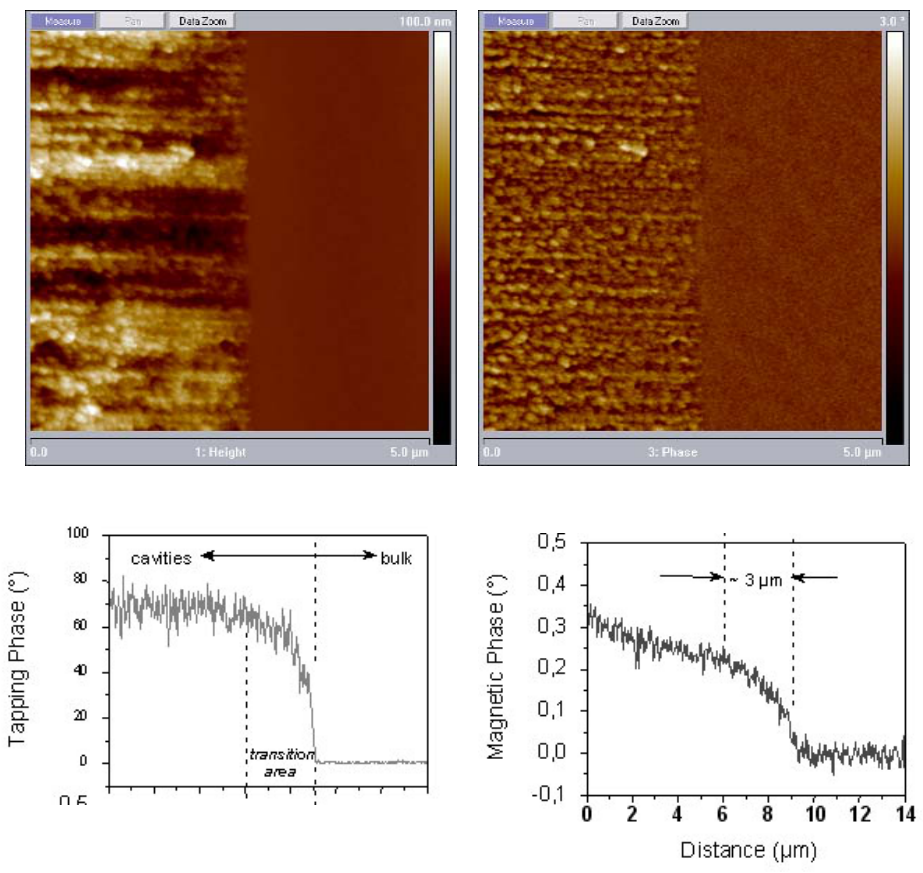
Figure 34. MFM-measurements performed in tapping mode (left) and magnetic mode (right) respectively showing the abrupt change between silicon and porous silicon and also the sharp difference between non-magnetic and magnetic material